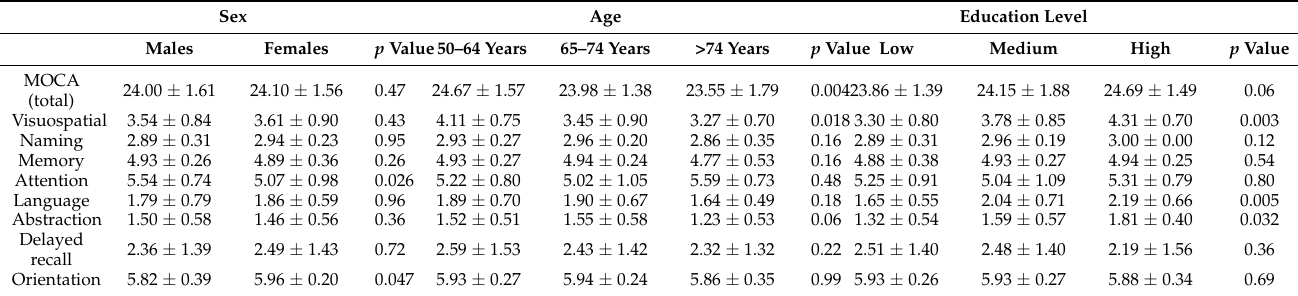
Table 4. Effects of characteristics of subjects on MoCA total score and its sub-domains in subjects with MCI.